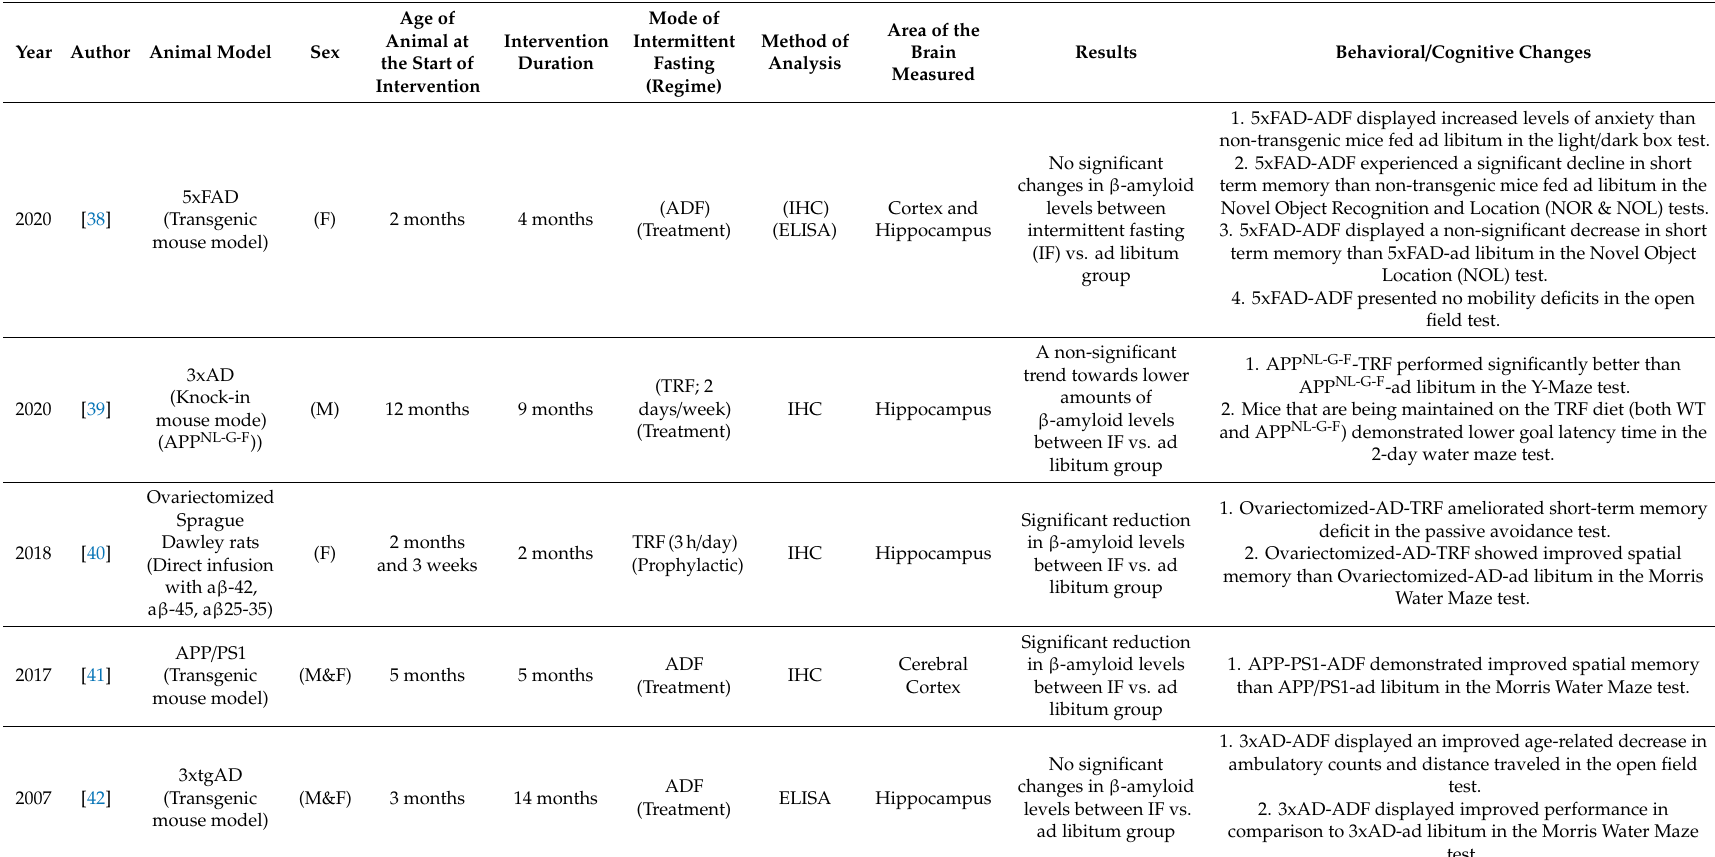
Table 1. The summary of data extracted from eligible